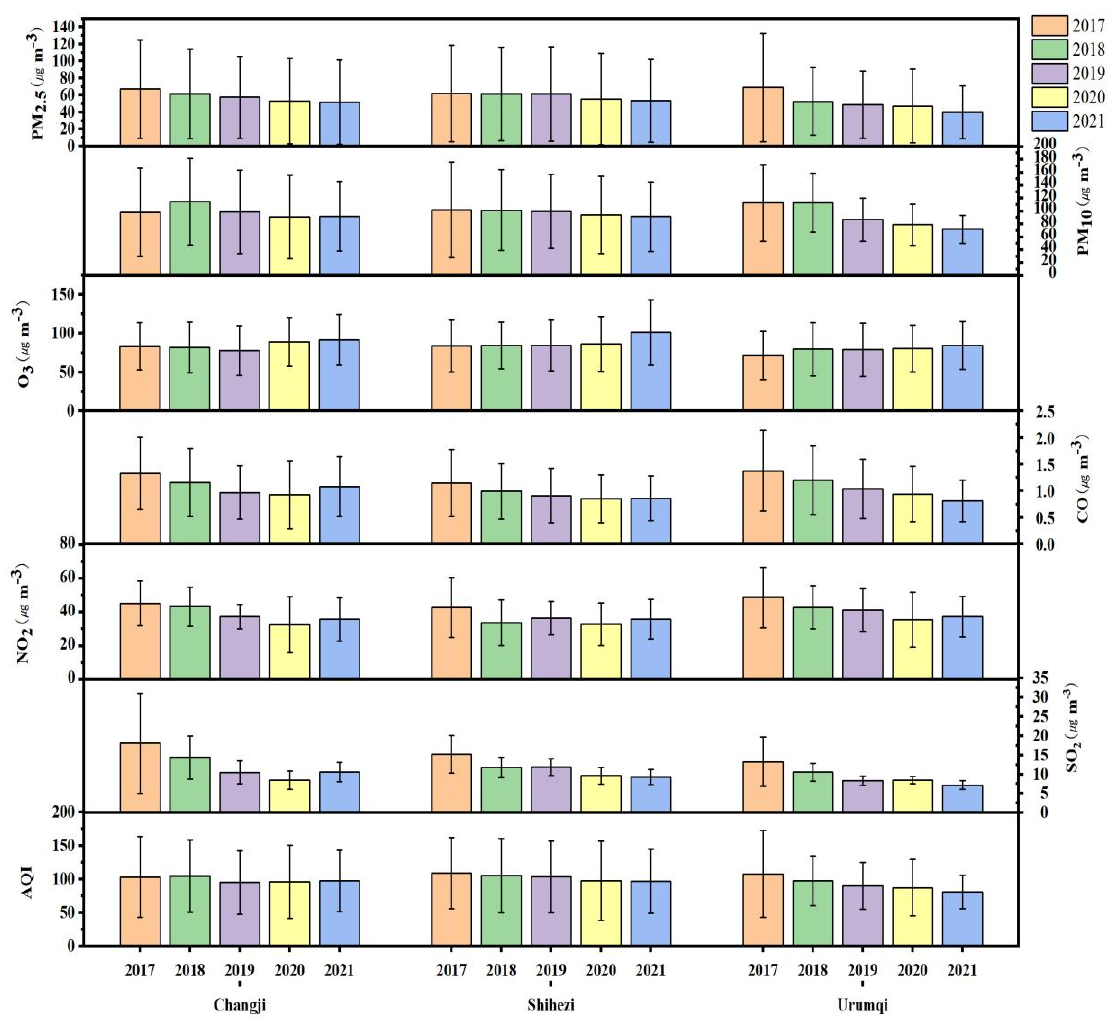
Figure 2. Comparison of the AQI and annual average concentrations of air pollutants in the Wu- Chang-Shi urban for 2017–2021. ( μ g m − 3 ).